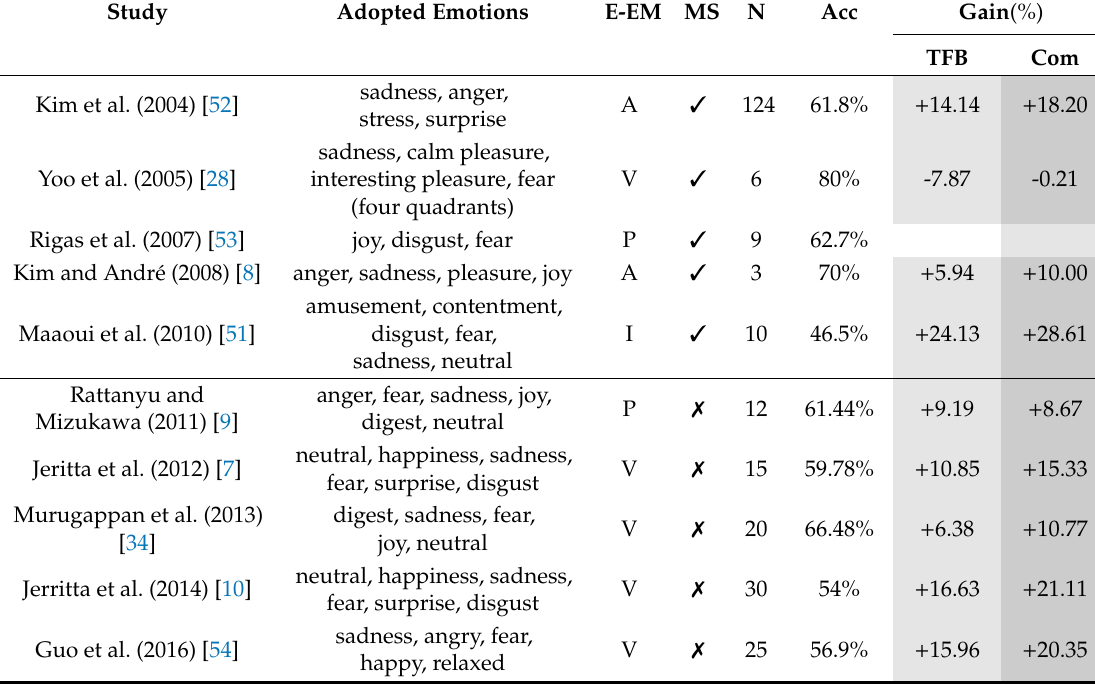
Table 8. Comparison with the